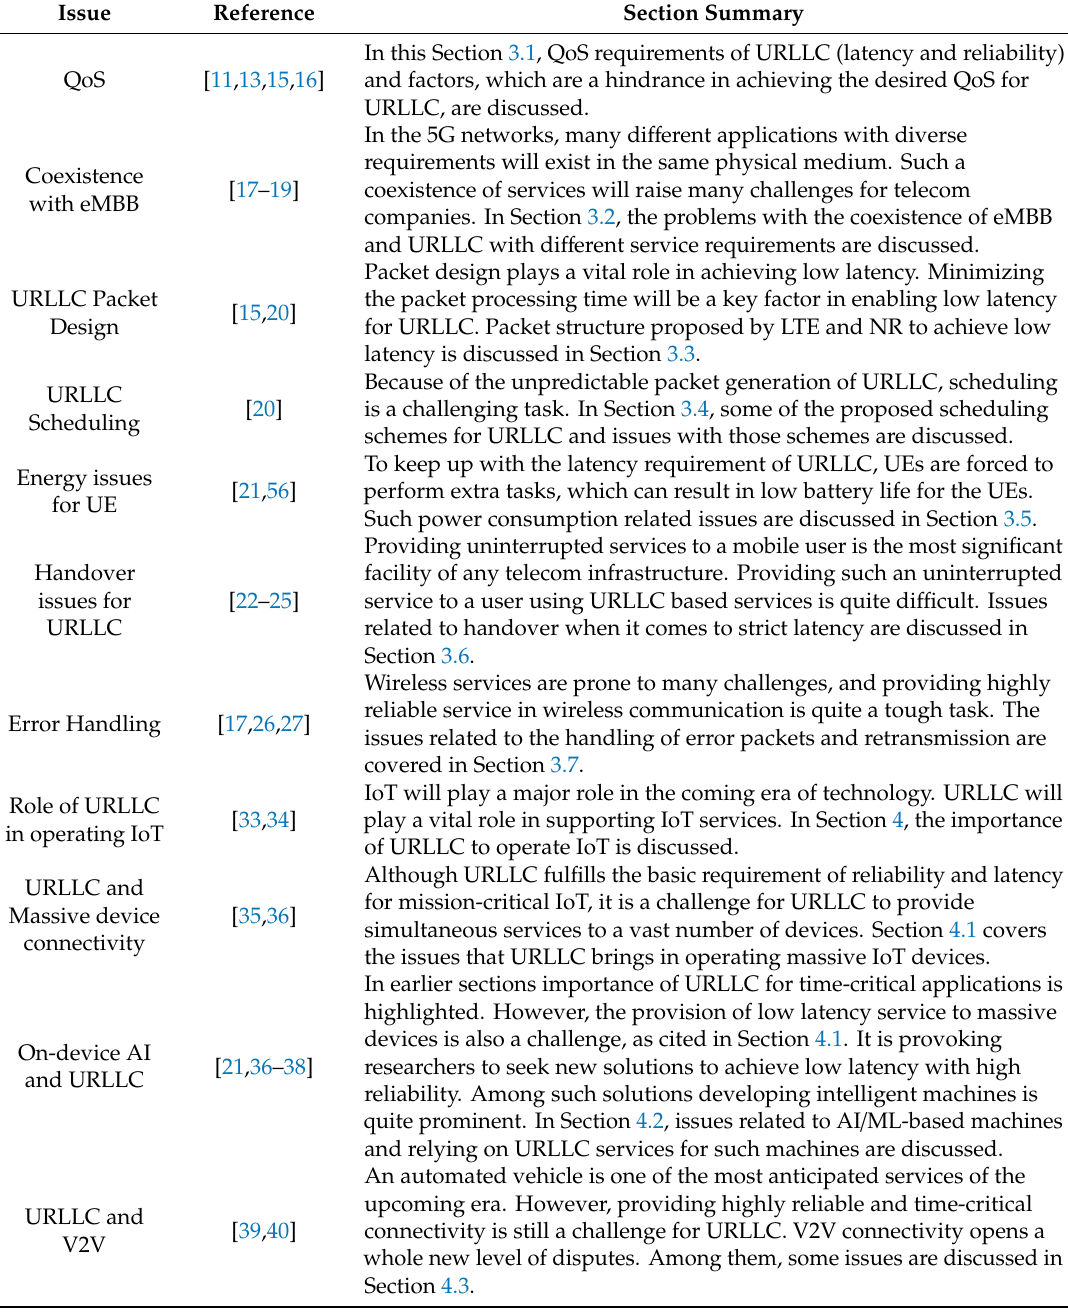
Table 6. Summary of issues discussed in the paper. AI, artificial intelligence; ML, machine